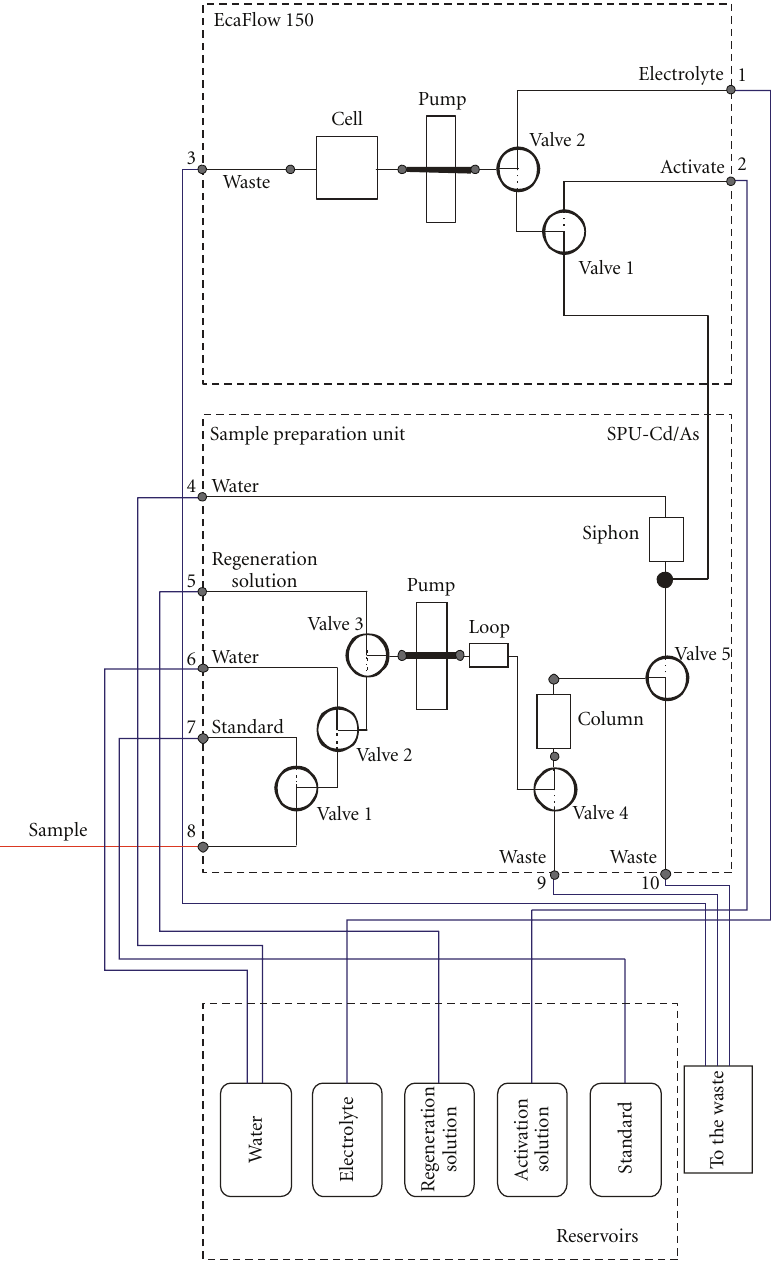
Figure 1: Flow chart diagram of the Cd/As measuring system. See explanation in the